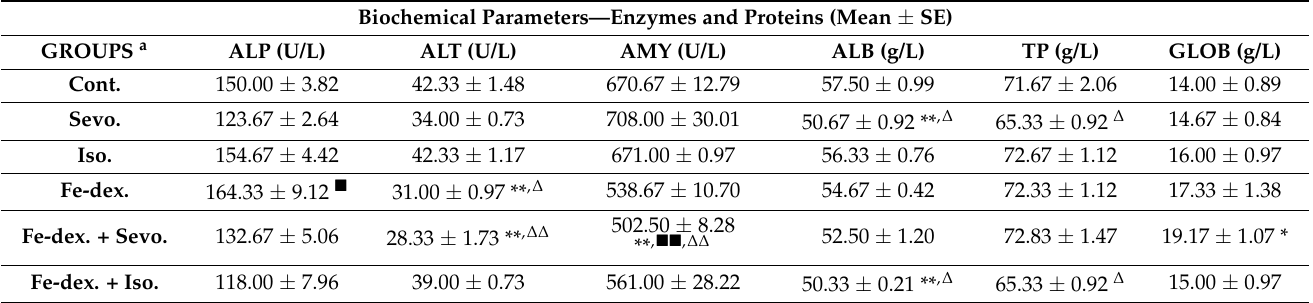
Table 1. Biochemical values of enzymes and proteins from the blood of rats treated with inhaled anesthetics and iron dextran and their combination.